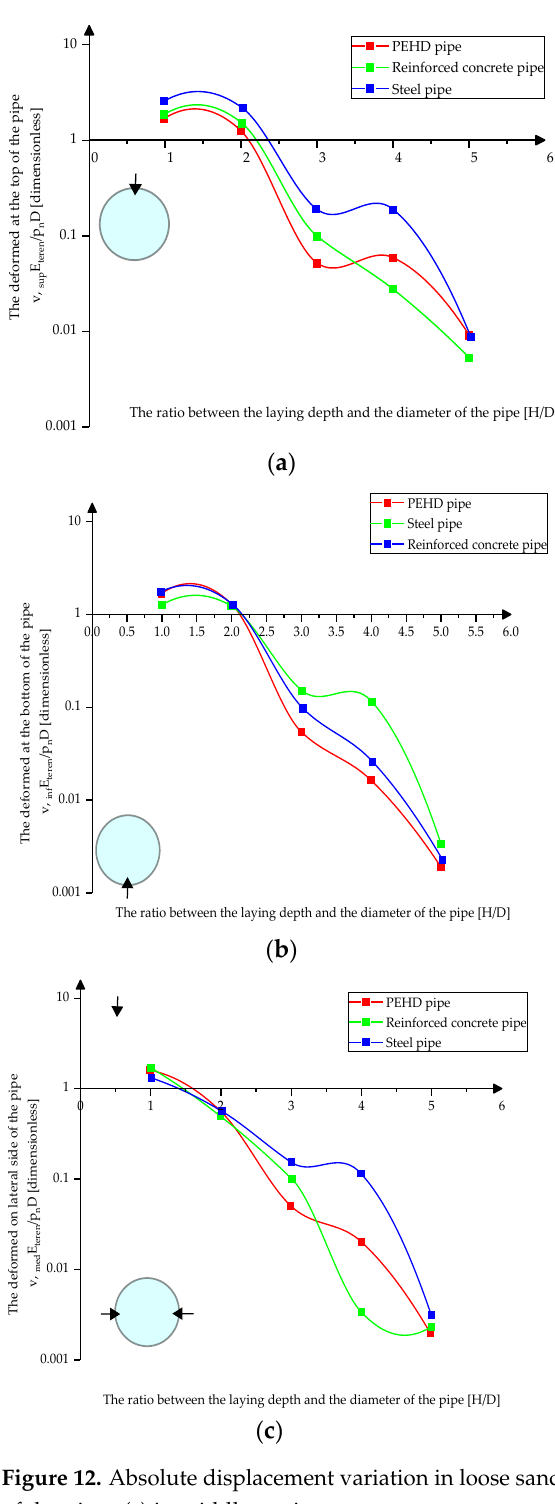
Figure 12. Absolute displacement variation in loose sand ( a ) at the top of the pipes ( b ) at the bottom of the pipes ( c ) in middle sections.